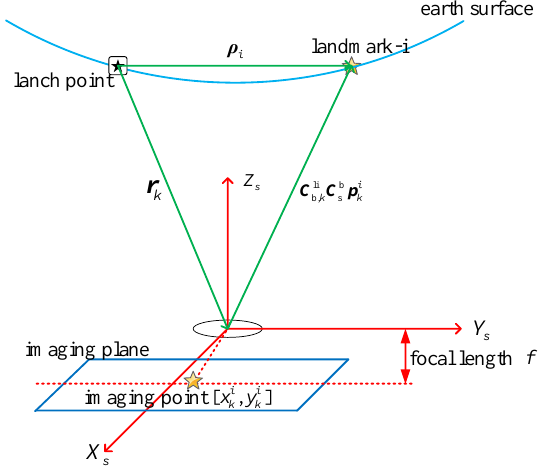
Figure 2. Schematic diagram of LINS observation